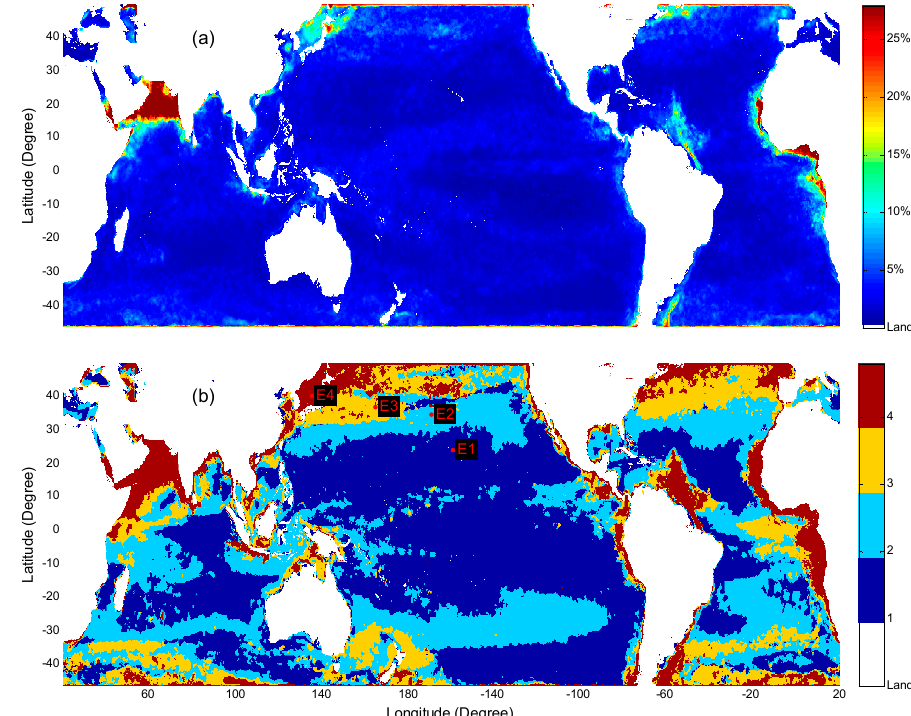
Figure 8. ( a ) MRD values of Chl-a fitted by Equation (3) in the unit of percentage. ( b ) The classification based on MRD of the three equations with Class 1 ( < 5% for Equation (1)), Class 2 ( ≥ 5% for Equation (1) and < 5% for Equation (2)), Class 3 ( ≥ 5% for Equation (2) and < 5% for Equation (3)), and Class 4 ( ≥ 5% for Equation (3)), respectively. Four sites (marked as E1–E4) are selected from each class for the comparisons of the fitted values and satellite data in detail.